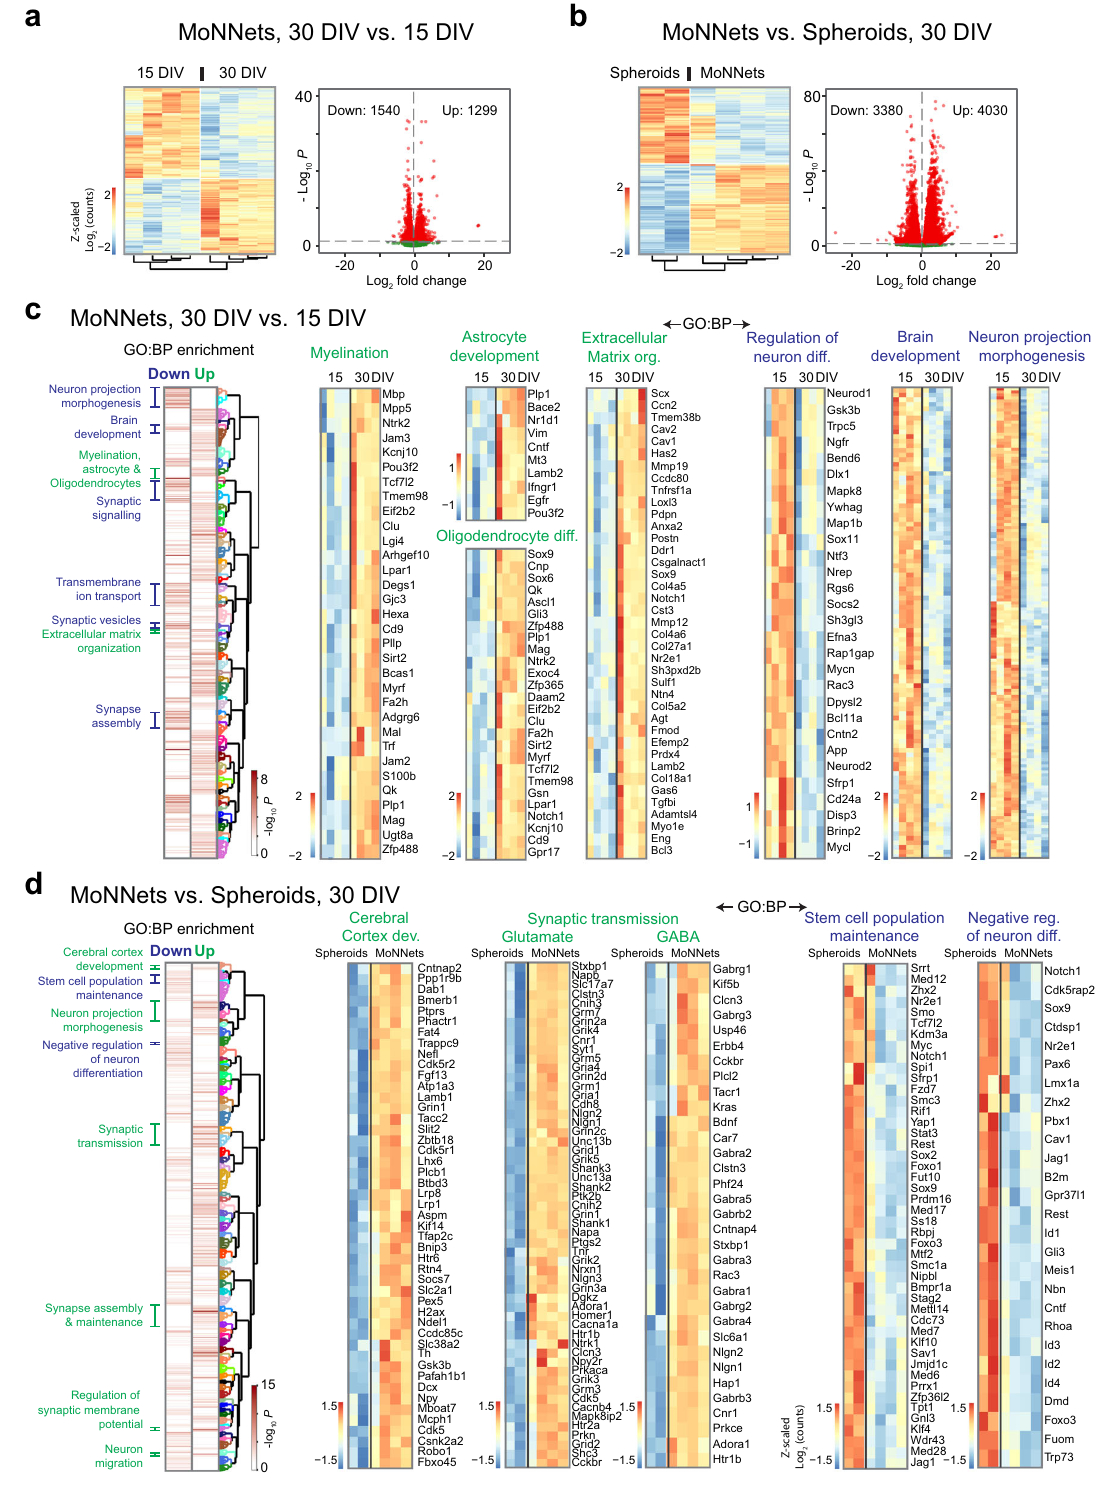
Fig. 4 Characterizing the gene expression differences in MoNNets and spheroids. a Heat map and volcano plot of differential gene expression (DESeq2, padj < 0.05) in MoNNets at DIV30 relative to DIV15. b Heat map and volcano plot of differential gene expression (padj < 0.05) in MoNNets relative to spheroids at DIV30. c Comparative enrichment of Gene Ontology: Biological Process (GO:BP) terms in up (green) and down (blue) regulated genes in MoNNets at DIV30, relative to DIV15. Gene expression heat maps are shown for speci fi c GO:BP terms. Also see Supplementary Fig. 9 for gene names associated with “ Brain development ” and “ Neuron projection morphogenesis ” terms. d Comparative enrichment of GO:BP terms in up (green) and down (blue) regulated genes in MoNNets, relative to spheroids. All sample replicates are biological. Also see Supplementary Fig. 10 for details of GO:BP terms clusters. Gene expression heat maps are shown for speci fi c GO:BP